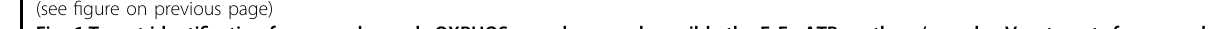
Fig. 6 Target identi fi cation for arzanol reveals OXPHOS complexes and possibly the F 1 F O ATP synthase/complex V as targets for arzanol. A Mass spectrometry (MS)-based target identi fi cation by af fi nity puri fi cation from HeLa cell whole lysates, and af fi nity puri fi cation and DARTS experiments from lysates of isolated mitochondria from HeLa cells reveal 125 novel potential targets of arzanol. B Cellular metabolism analysis was performed using a Seahorse Mito Stress Test Kit. Cells were incubated with arzanol for 15 min after measurement of the basal respiration and OCR was measured in at least octuplicates in three independent experiments. One representative experiment is shown (upper diagram). Respiration after treatment, maximal respiration, proton leak, and non-mitochondrial respiration were normalized to the basal respiration (lower diagram). Non- mitochondrial respiration = minimum rate measurement after rotenone/antimycin A injection; basal respiration = last rate measurement before fi rst injection minus non-mitochondrial respiration; maximal respiration = maximum rate measurement after FCCP injection minus non-mitochondrial respiration; proton leak = minimum rate measurement after oligomycin injection minus non-mitochondrial respiration. C Arzanol inhibits mainly OXPHOS complexes II and III in a respiratory chain activity assay of isolated mitochondria after incubation for 15 min and 60 min. Complex activities were measured using the MitoCheck ® kits in technical triplicates and normalized to the DMSO control. Bars show mean + SEM. D DARTS experiment validates selected OXPHOS complex proteins of complexes II and III. The lysate of isolated mitochondria from HeLa cells was incubated with 1 or 10 µM arzanol and then subjected to subtilisin-dependent proteolytic cleavage. Arzanol stabilized SDHB, HSP9A, UQCRFS1, CPS1, and GARS1 against subtilisin treatment. Nonadjacent lanes (i.e., lysate control lane) are indicated by vertical black lines. Please note that in the SDHB/HSP9A panel the loading of the samples for 1 and 10 µM arzanol treatment are exchanged . E Arzanol reduces the enzyme activity in an NQO1 activity assay similar to the positive control 20 µM dicoumarol. Lysate from wild-type HeLa cells was subjected according to the manufacturer ’ s manual. Bars show mean ± SEM of biological quadruplets. Statistical analysis was performed using a one-way ANOVA with Dunnett ’ s multiple comparison test comparing treated to untreated control samples; *** P < 0.001, **** P <